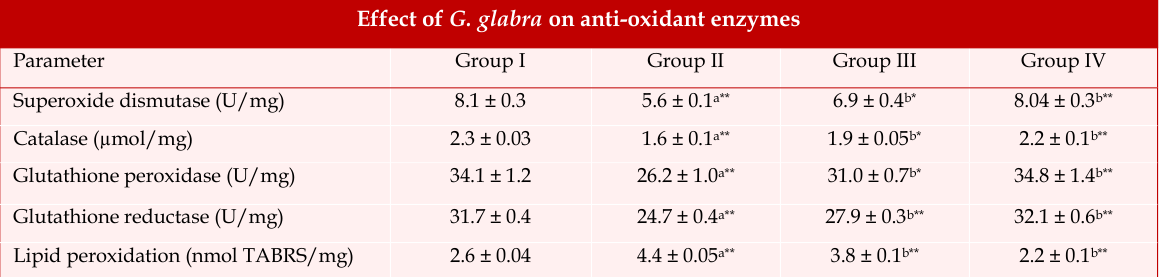
Effect of G. glabra on anti-oxidant